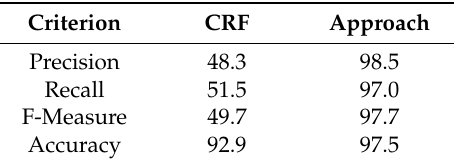
Table 4. Precision, recall, F-measurement and accuracy in % of House B in comparison with the benchmark (CRF).